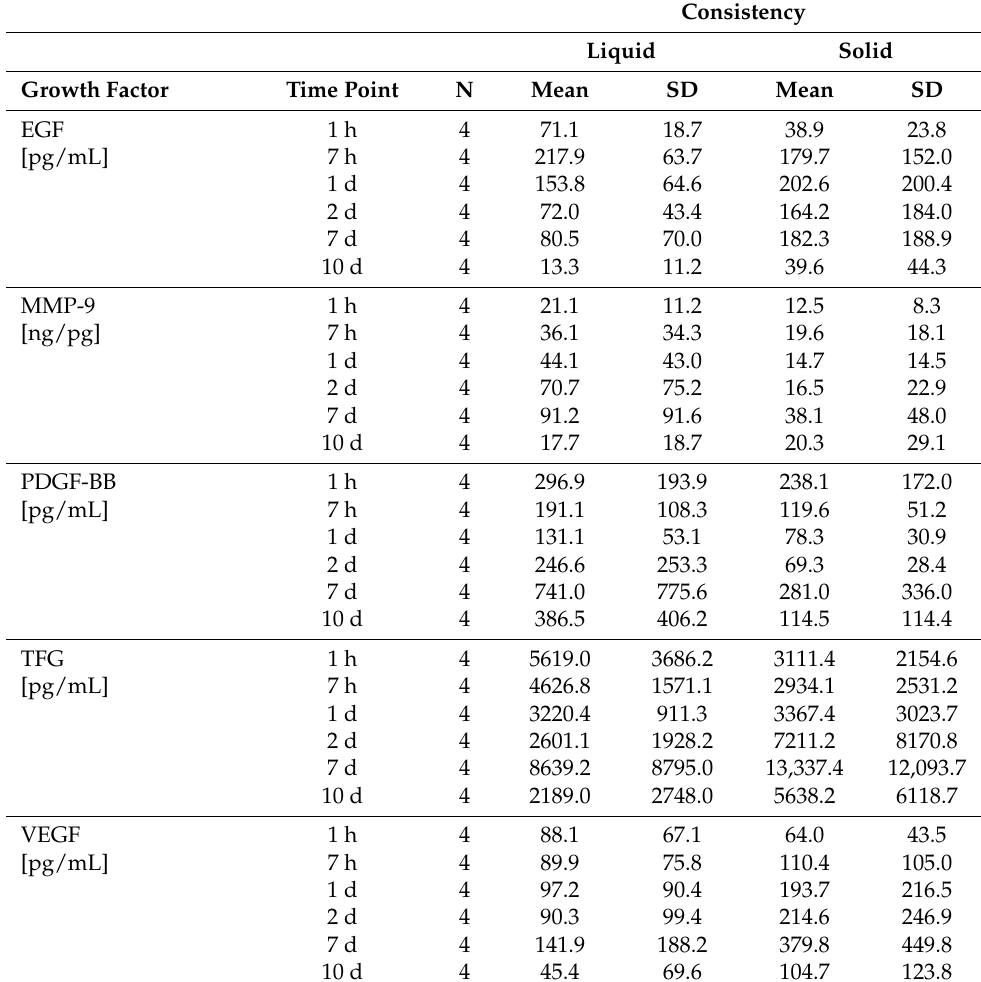
Table 1. Descriptive statistics growth factor release of liquid and solid